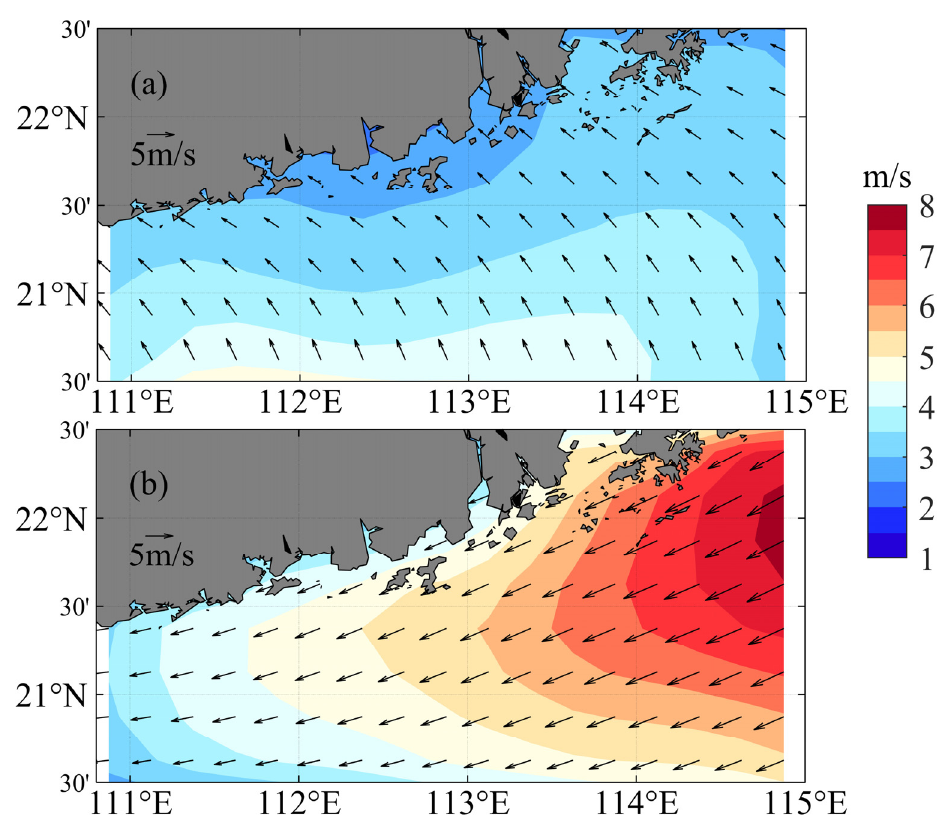
Figure 8. Surface winds overlaid with wind speed (color shading, unit: m/s), averaged over 12–18 April ( a ) and 13–20 May ( b ) 2016.